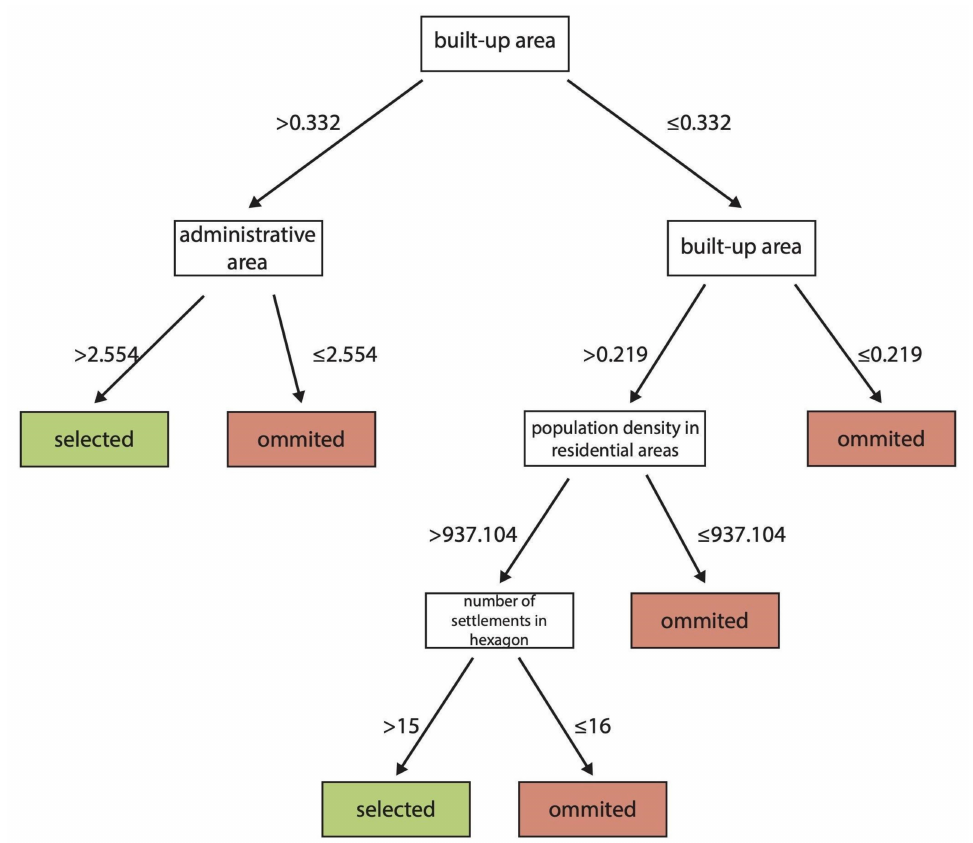
Figure 8. Decision tree for group 3, result of machine learning using the DT-GA